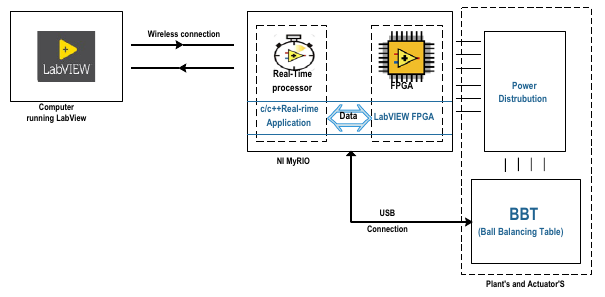
Fig. 2 Block diagram of the ball balancing